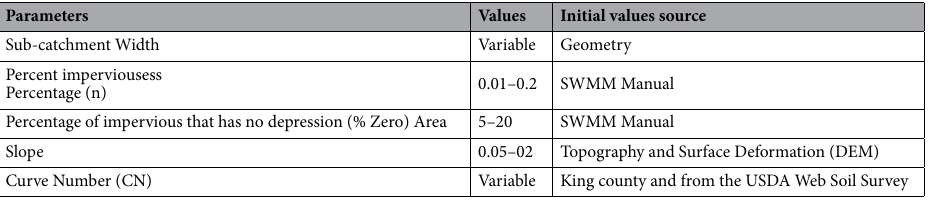
Table 3. SWMM parameters for the sensitivity